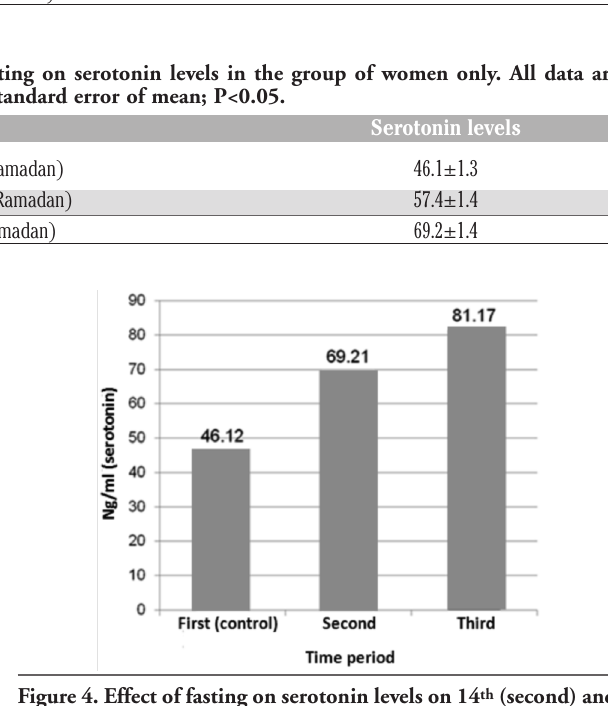
Figure 4. Effect of fasting on serotonin levels on 14 th (second) and 29 th (third) day of Ramadan compared to the control group. All data are expressed as mean±standard error of mean;